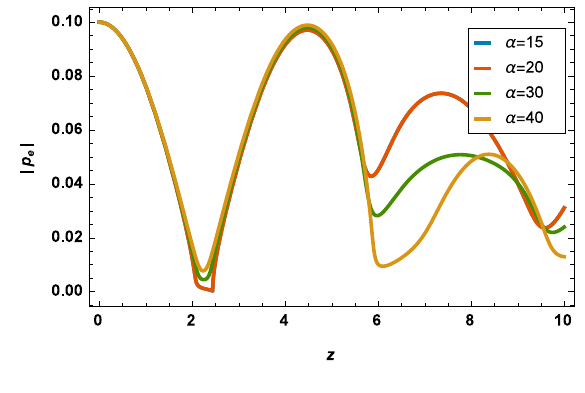
Fig. 10 Pressure along Constricted Tube for Various Values of α with λ a = 0 . 5 , β = 0 .